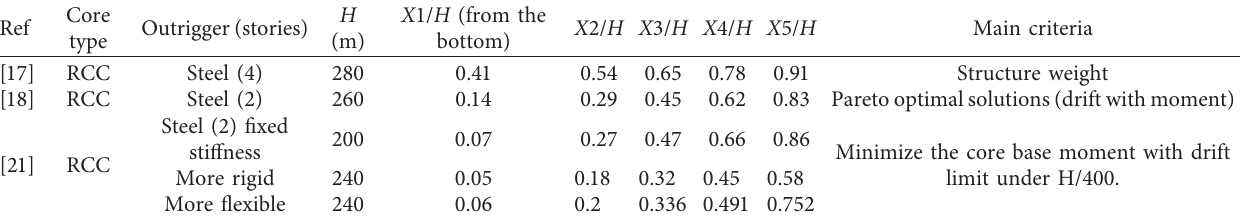
Table 9: Five outrigger structures.